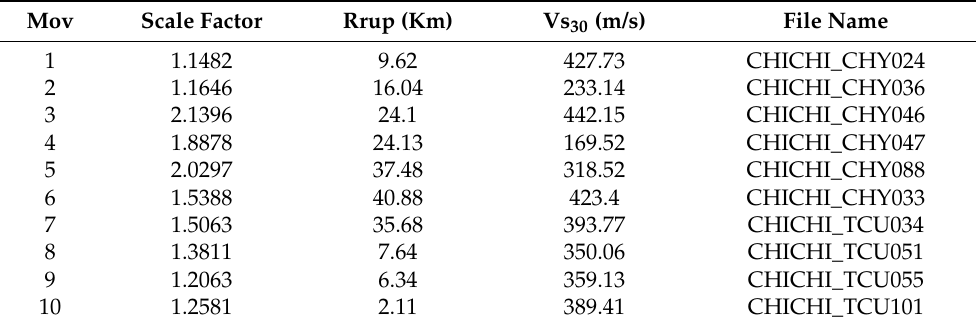
Table 8. Seismological characteristics of the scaled seismic movements for a profile D soil. The 7.2 Mw seismic event in Chichi, Taiwan in 1999 was a reverse oblique